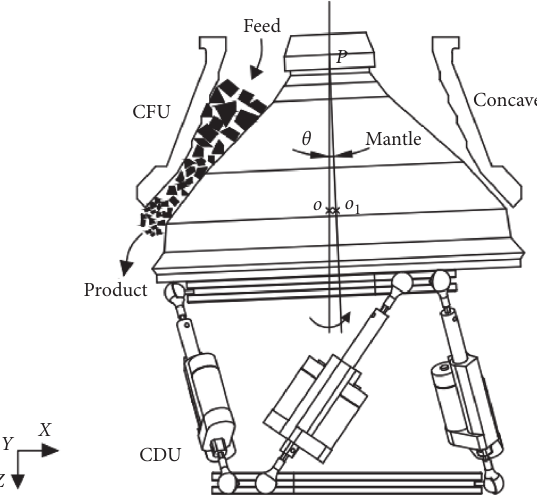
Figure 1: Schematic of the 6-DOF robotic crusher.